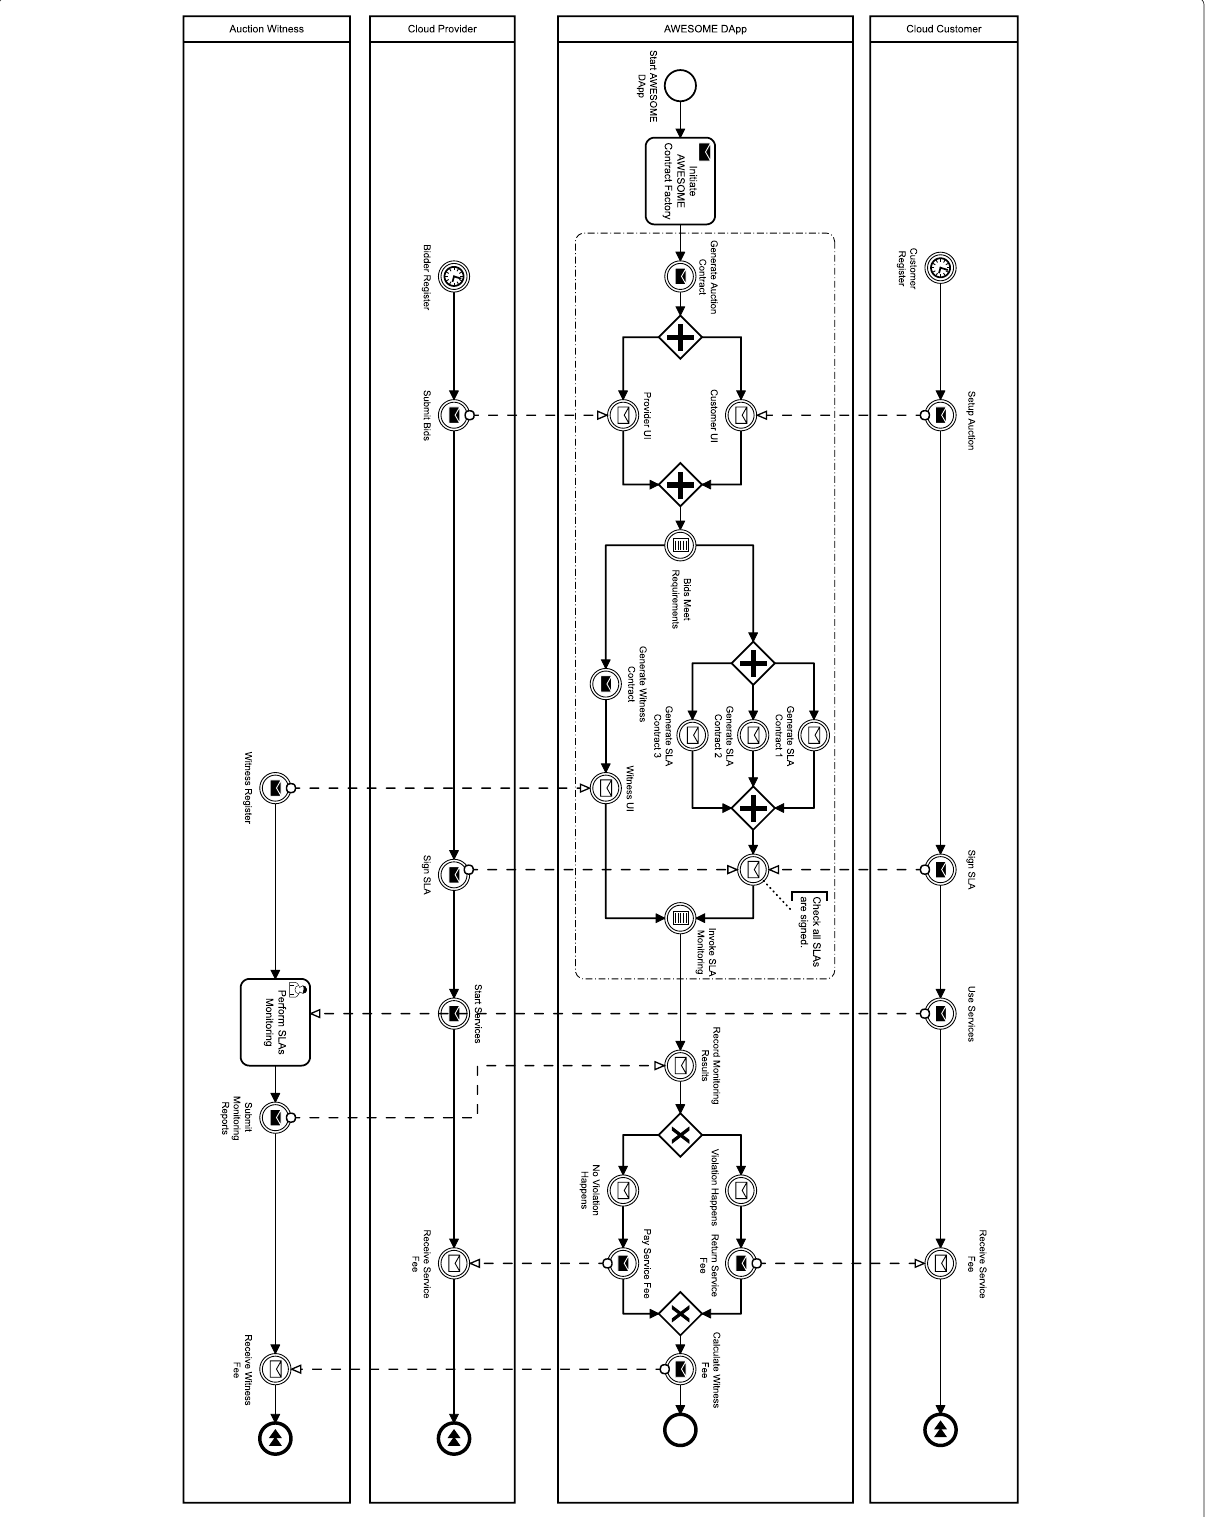
Fig. 8 The business processes in an AWESOME service trading